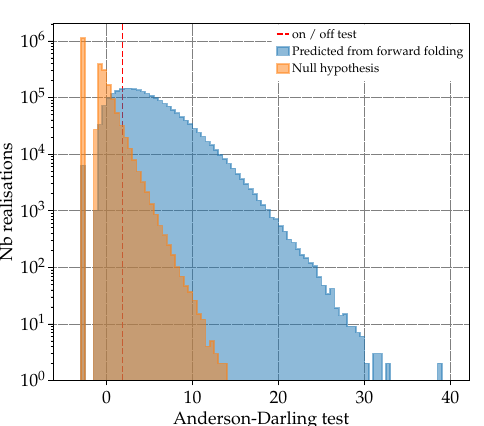
Figure 12: Anderson-Darling test from randomized skies (orange) and from forward folding (blue) for the out- FidFoV data set. The red dashed line indicates the value obtained for data in the on / o ↵